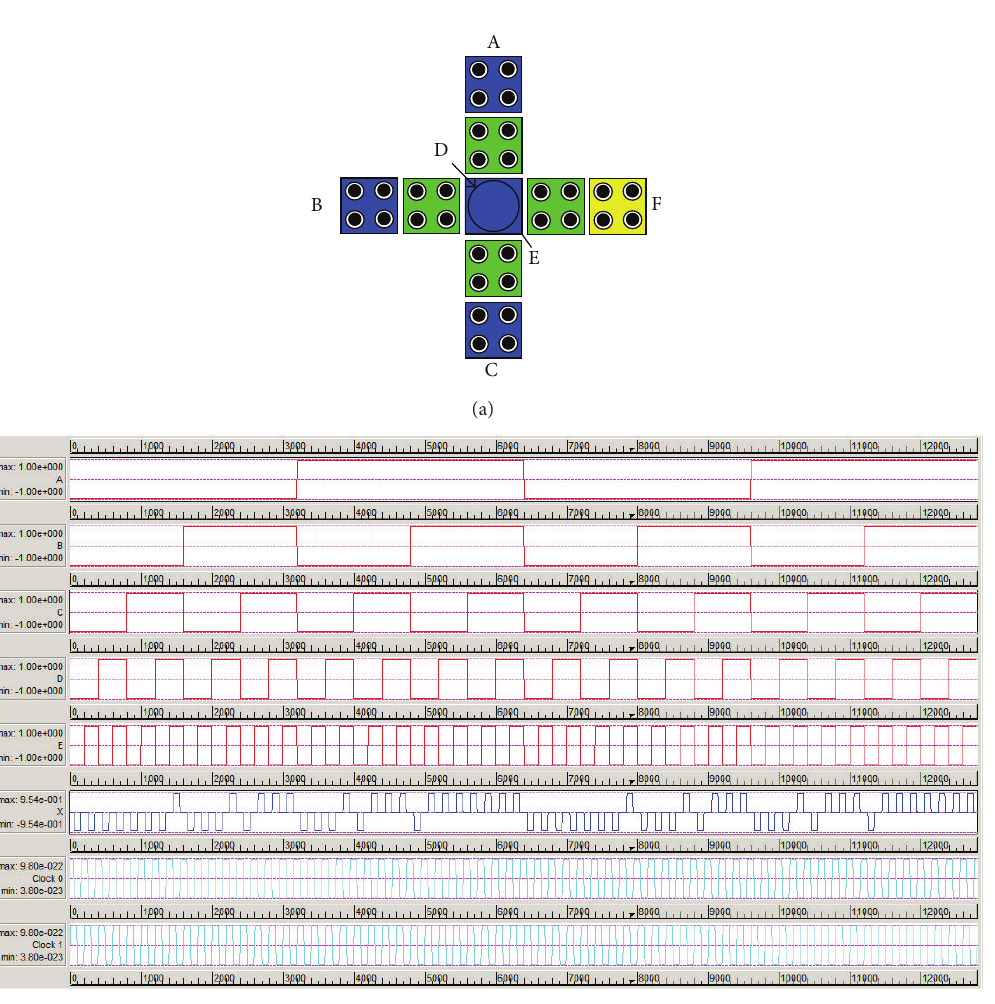
Figure 4: QCA cell layout and its simulation result of five-input majority